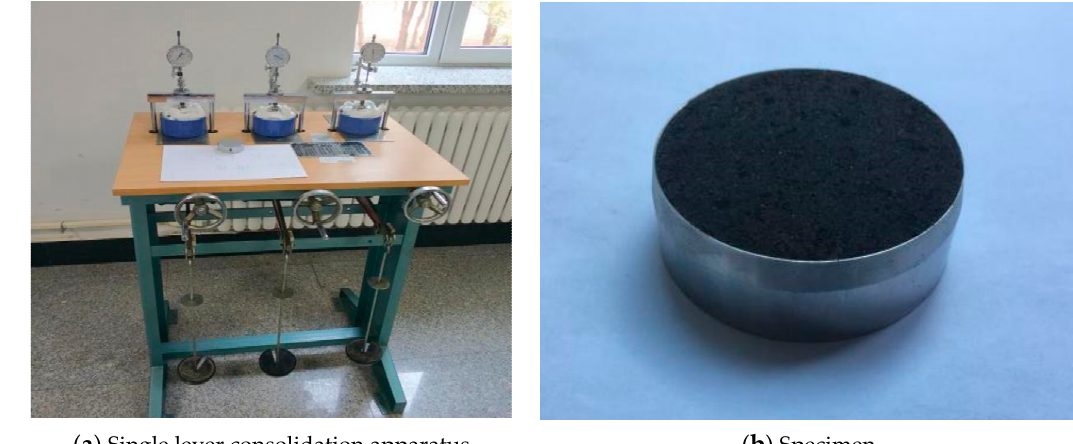
Figure 2. Diagrams of test apparatus and specimen.